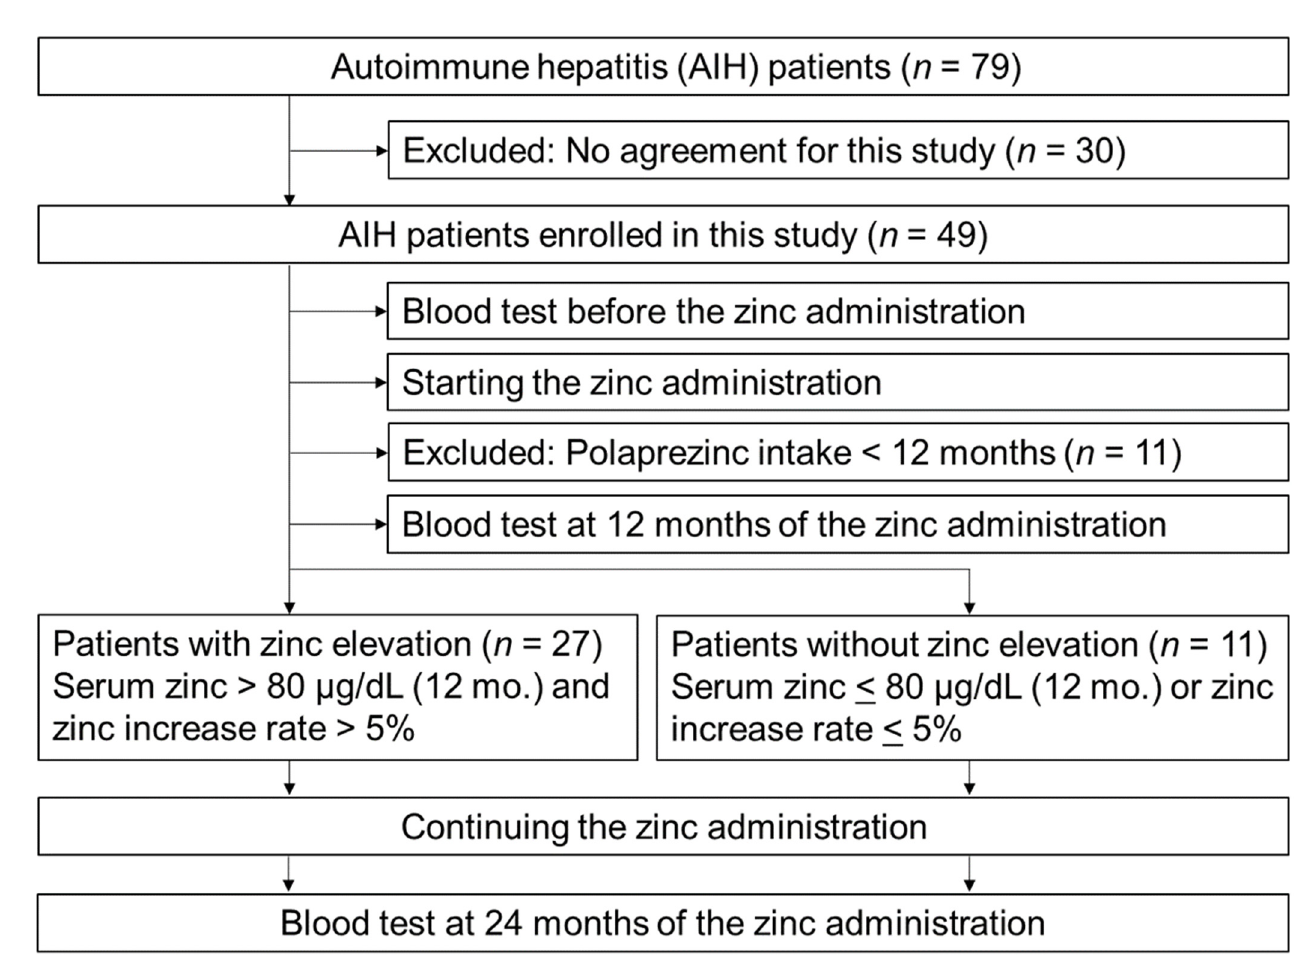
Figure 1. Patient flowchart. A total of 49 patients with AIH were initially included in analysis, 11 of whom were excluded because they withdrew polaprezinc intake within 12 months; 38 patients treated with polaprezinc for >24 months were enrolled and were divided into two groups based on serum zinc level and its increase rate.